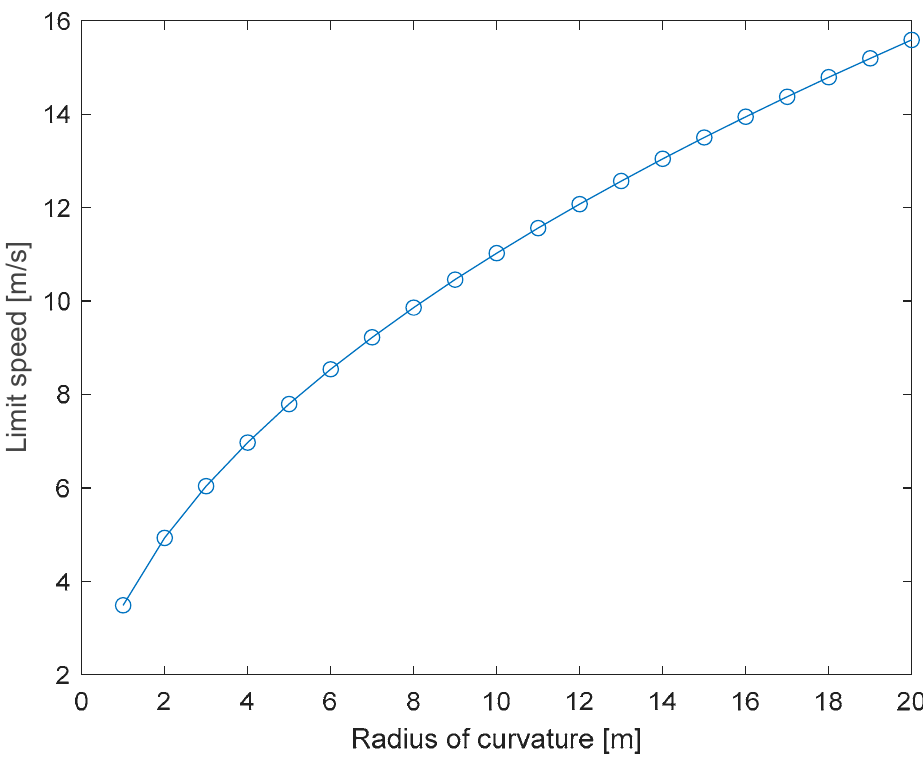
= 62 cm. Figure 30. Capsizing speed limit for h = 50 cm and b 2 = 62 (cid:2870)